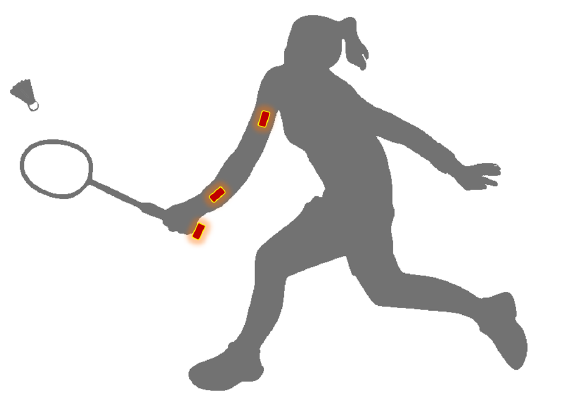
Figure 2. Positions